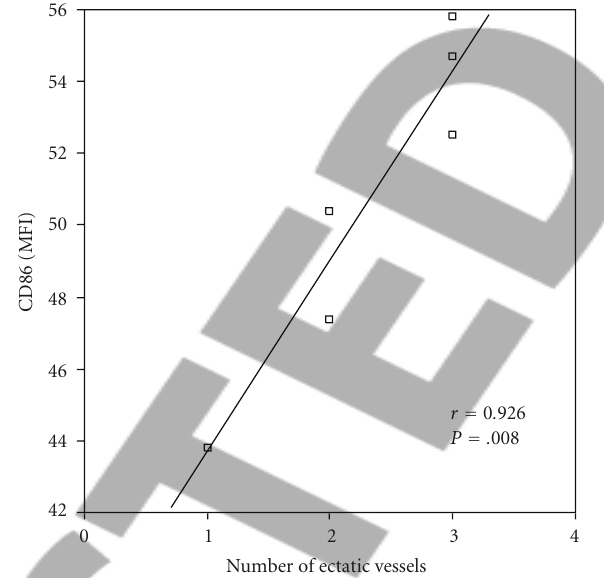
Figure 2: The graph showing the relationship between the number of ectatic vessels and the expression level of CD11c molecule. r : Spearman’s rho correlation coe ffi cient. MFI: mean fluorescence intensity.